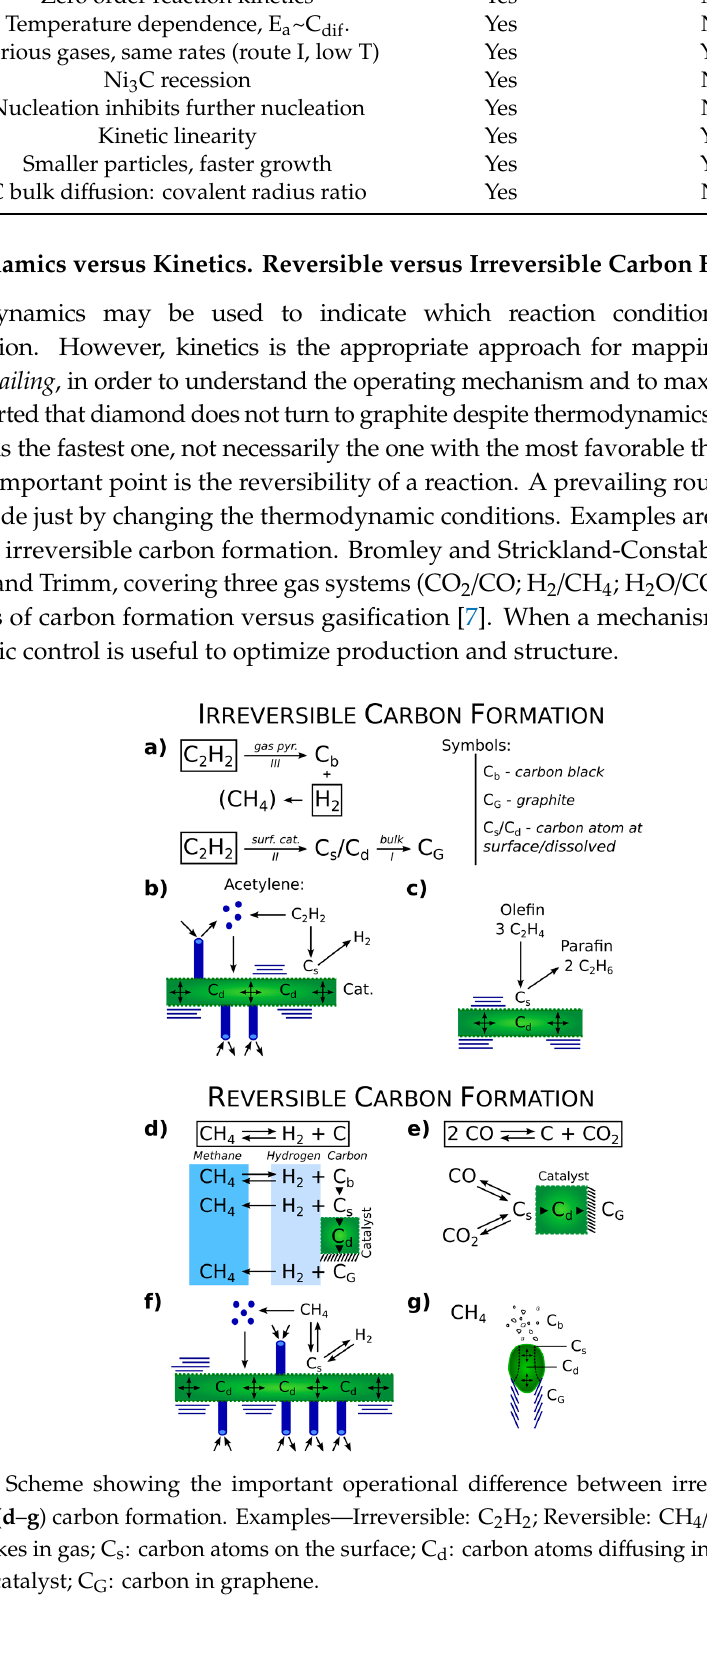
Table 1. Evidence of C bulk diffusion operating, not surface diffusion , based on the kinetic behavior. Observed Behavior Bulk Diffusion Surface Diffusion Zero order reaction kinetics Yes No Temperature dependence, E a ~C dif . Yes No Various gases, same rates (route I, low T) Yes Yes Ni 3 C recession Yes No Nucleation inhibits further nucleation Yes No Kinetic linearity Yes Yes Smaller particles, faster growth Yes Yes C bulk diffusion: covalent radius ratio Yes No